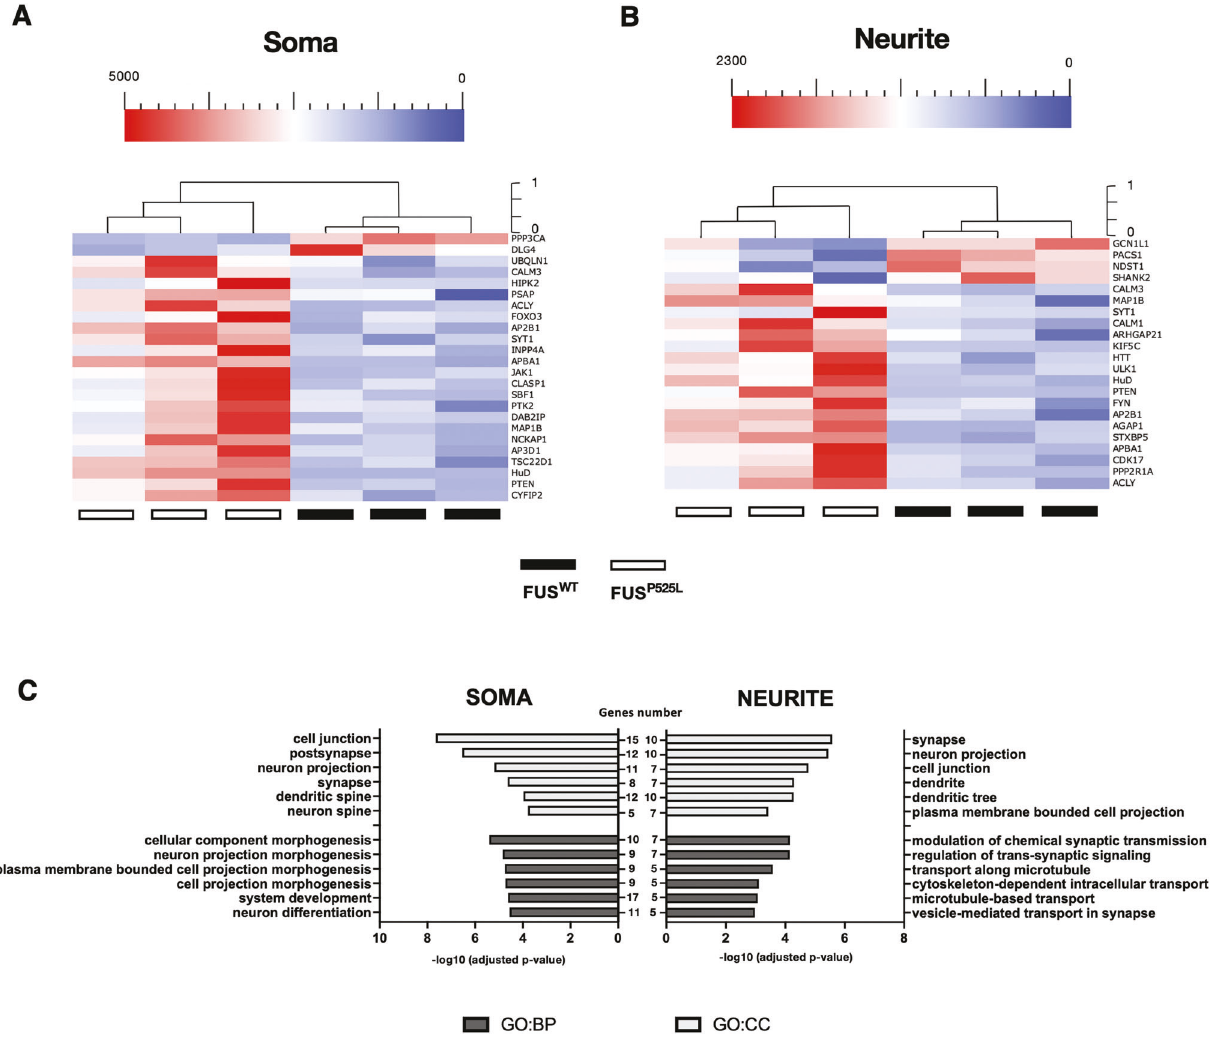
Fig. 2 Differentially expressed genes in soma and neurite of FUS WT and FUS P525L MNs. A , B Unsupervised cluster representing the RNA molecules count of differentially expressed genes in the cell body ( A ) or neurite ( B ) compartment of iPSC-derived FUS WT and FUS P525L MNs. Plotted values correspond to normalized RNA molecules as described in the Methods section. Red, higher abundance; blue, lower abundance. C Bar graph representation of the top 6 GO terms enriched in differentially expressed genes as in ( A , B ). The − log10(adjusted p -value) and number of genes are